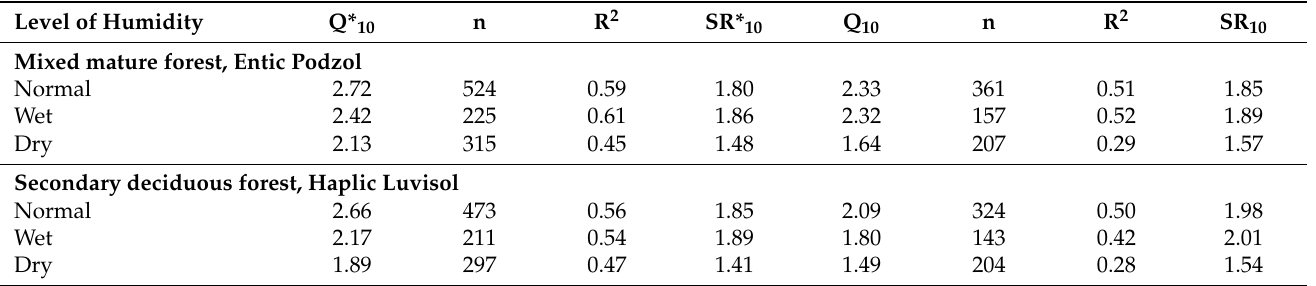
Table 2. Temperature coefficients (Q* 10 and Q 10 ) of soil respiration, SR* 10 , and SR 10 values for periods of different levels of humidity in the two types of